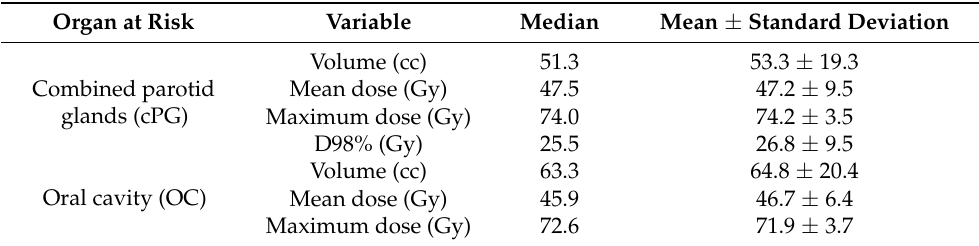
Table 2. Volumes of organs at risk and the distribution of dosimetric parameters for the Nasopharyn- geal Cancer cohort used for model development.